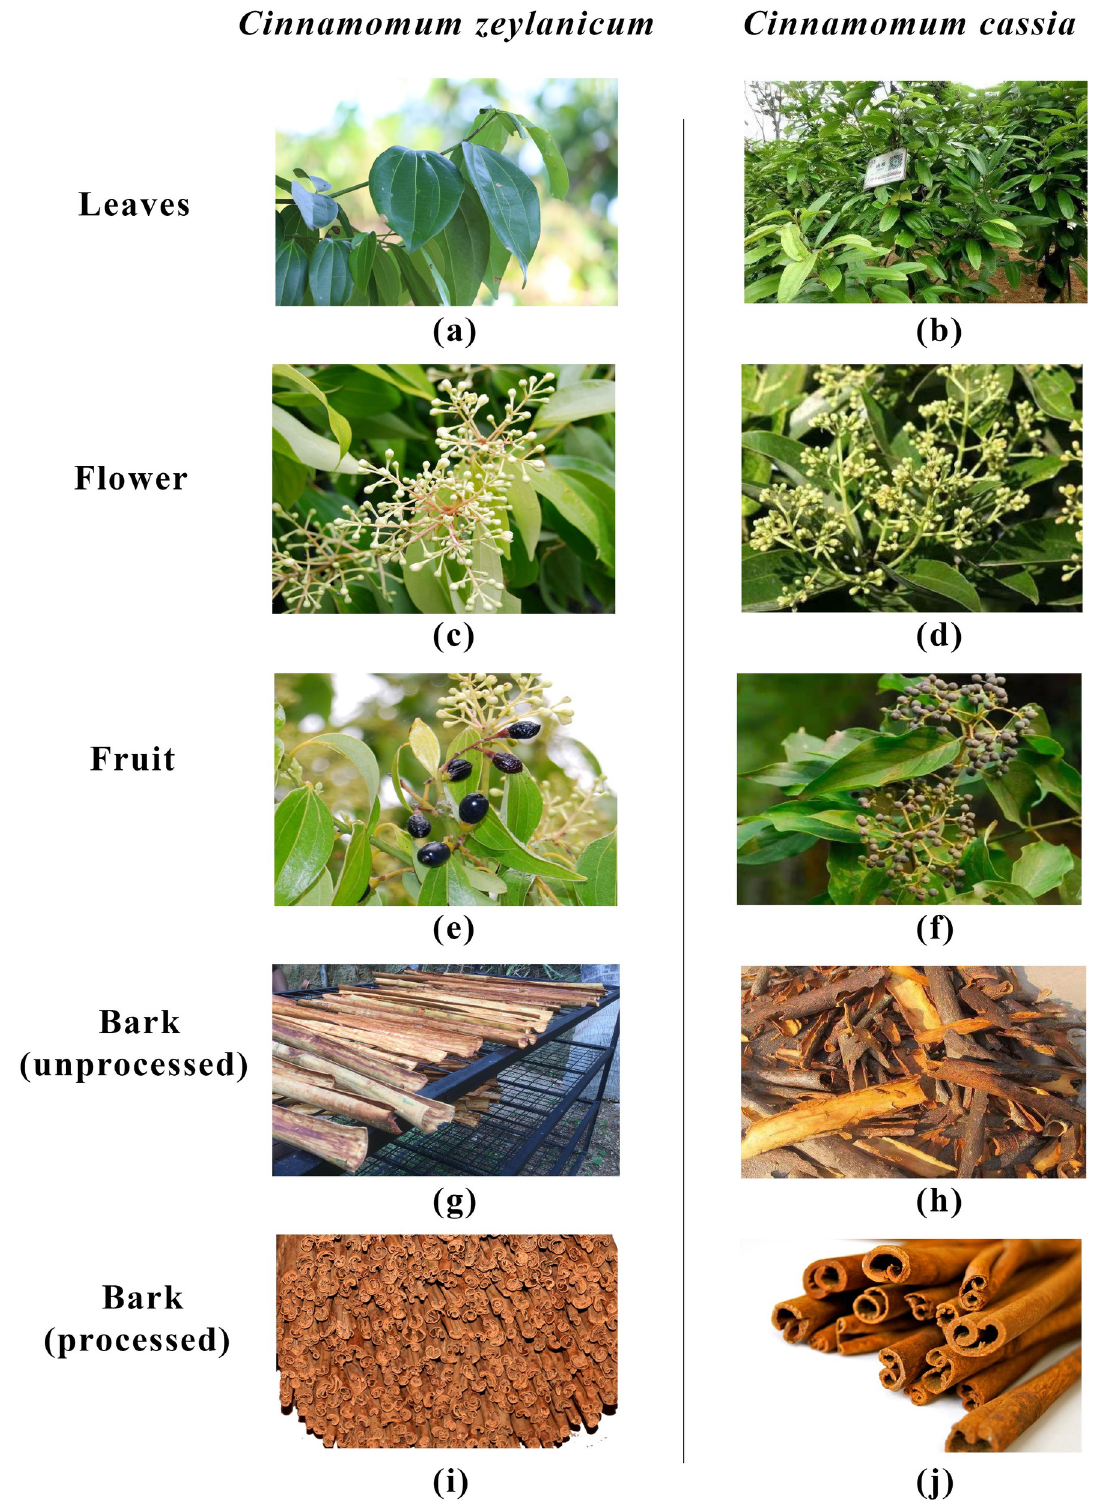
Fig 2. The images of Cassia vs Ceylon cinnamon to compare the morphological characteristics. Morphological characteristics of leaves, flowers, fruit, unprocessed bark and processed bark of C . zeylanicum Vs C . cassia is graphically compared.